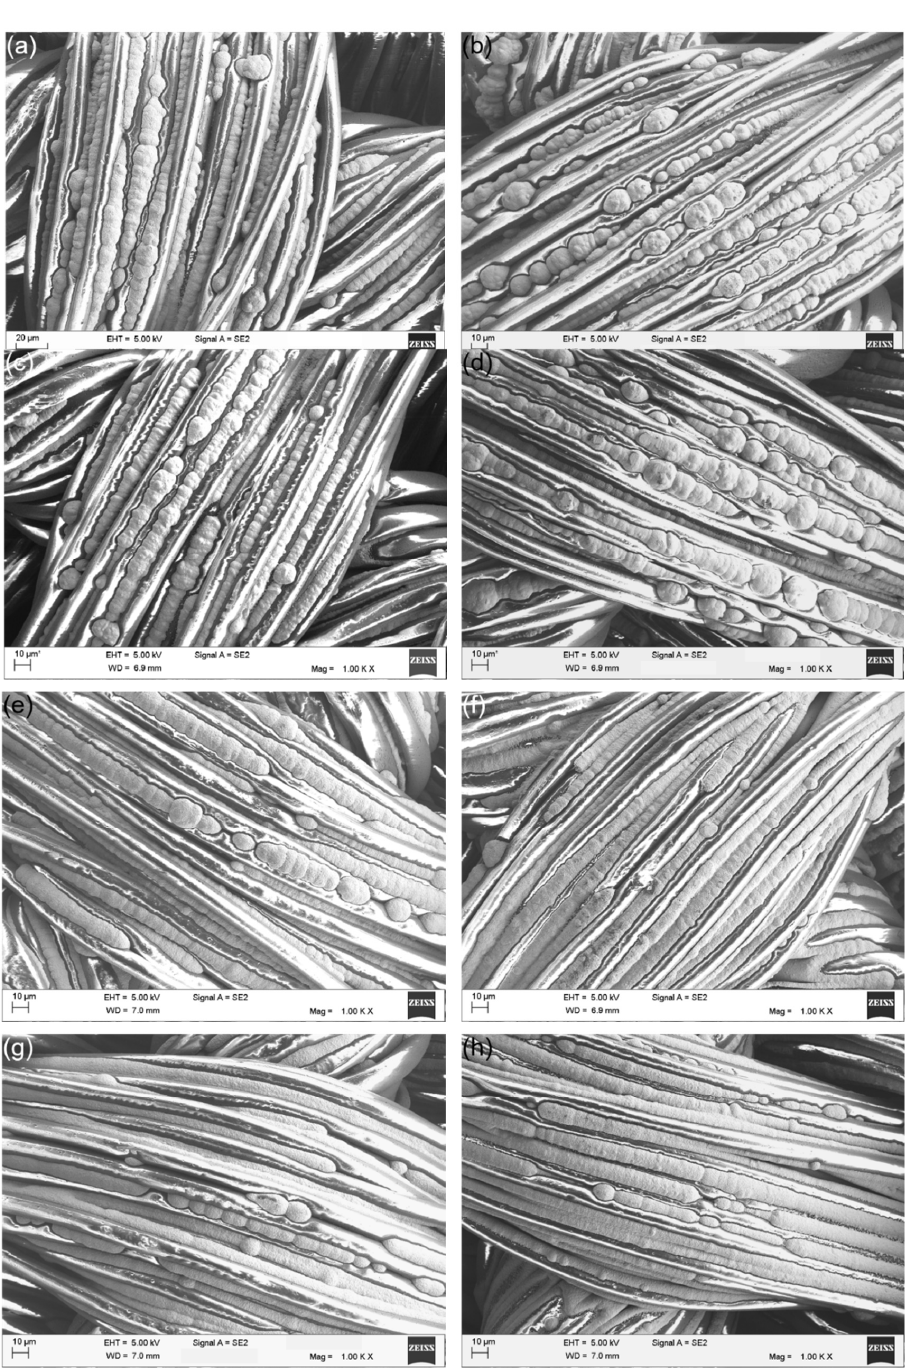
Figure 7. SEM micrographs of the metallised textiles printed with the Cu–Ag NP catalyst in the warp direction at ( a ) 2; ( c ) 3; ( e ) 4; and ( g ) 5 cycles; and in the weft direction at ( b ) 2; ( d ) 3; ( f ) 4; and ( h ) 5 cycles.